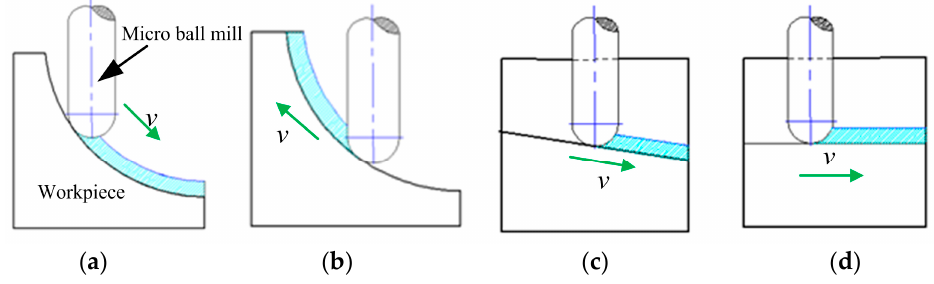
Figure 5. Contact type between the tool and workpiece material. ( a ) Downward cutting; ( b ) upward cutting; ( c ) oblique downward cutting; and ( d ) plane cutting.